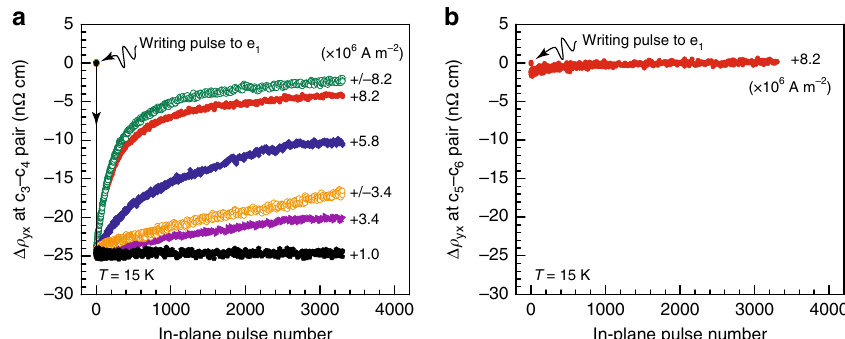
Fig. 3 Topological unwinding of the metastable SkS-L under current. a Variation in Δ ρ yx at the c 3 – c 4 pair for various pulse magnitudes in response to repeated in-plane pulses. b Δ ρ yx vs. in-plane pulse number at the c 5 – c 6 pair for an in-plane current pulse of +8.2 × 10 6 A m − 2 . Δ ρ yx , a good measure of the topological Hall signal, is obtained by offsetting the ρ yx value before applying the writing pulse to zero. Labels, such as “ 8.2 ” , represent the in-plane pulse magnitude used in the measurements, expressed in the unit of 10 6 A m − 2 . + (closed symbols) denotes the current fl owing from c 1 to c 2 (see Fig. 2c, d), and +/ – (open symbols) denotes the pulse sequence in which positive and negative pulses are applied in an alternating manner. Measurements were performed at 15 K and 0.249 T with a fi xed pulse width of 25